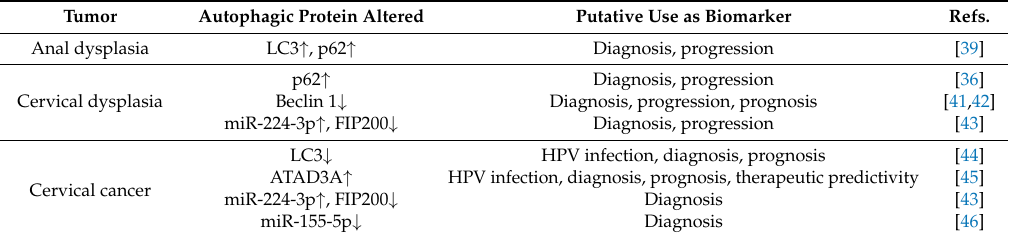
Table 1. Autophagy alterations during HPV-mediated tumor progression. Up and down arrows indicate increased and decreased expression of the reported proteins, respectively. ATAD3A: ATPase family AAA domain containing